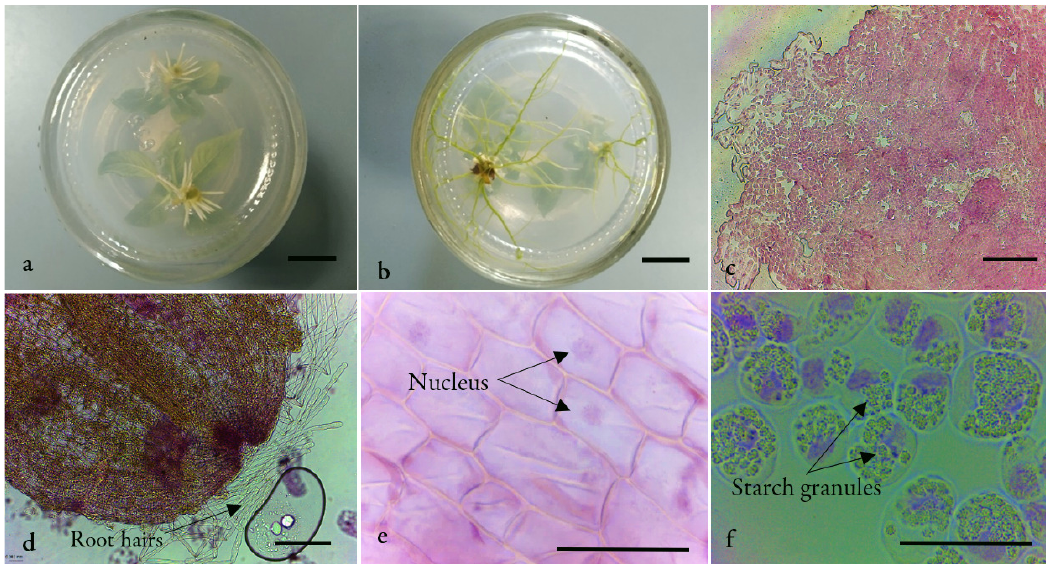
Figure 3. In vitro rooting and squashed root cells of N. cadamba . (a) 5-DO roots (Bar = 1 cm), (b) 20-DO roots (Bar = 1 cm), (c) root tip with well-spread cells (Bar = 0.2 mm), (d) root tip with root hairs without cell spread (Bar = 0.2 mm), (e) non-mitotic cells with very small nuclei with thick cell walls and in angular shape (Bar = 50 µm) and (f) cells with starch granules (Bar = 50